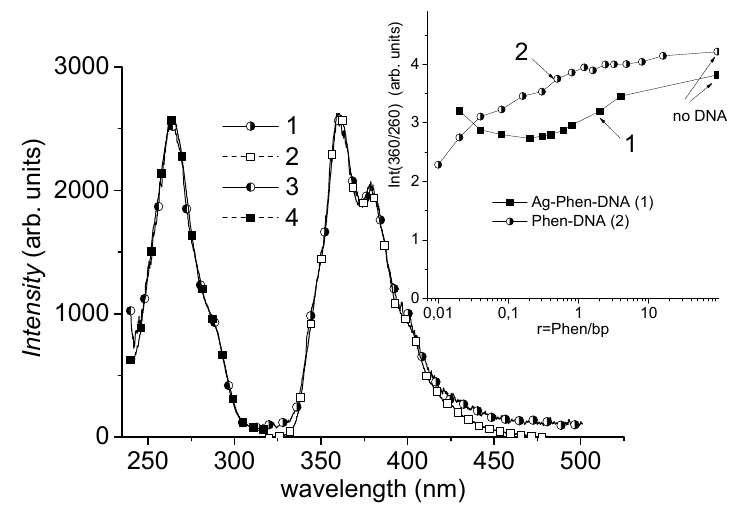
Figure 6. The luminescence of Ag–Phen and Phen complexes with DNA in 0.005 M NaNO 3 solution: emission (1, 2) and excitation (3, 4) spectra of Ag–Phen–DNA (1, 3) and Phen (2, 4). Spectra are normalized to the maximum intensities: λ ex = 260 nm, λ em = 360 nm, C AgPhen = 1.5 × 10 − 6 M, C DNA = 2 × 10 − 5 M (bp), C Phen = 3 × 10 − 6 M. The insert shows dependencies of Ag–Phen and Phen luminescence intensities at 360 nm ( λ ex = 260 nm) on relation of Phen to DNA base pairs concentrations ( C Phen = 3 × 10 − 6 M = const).